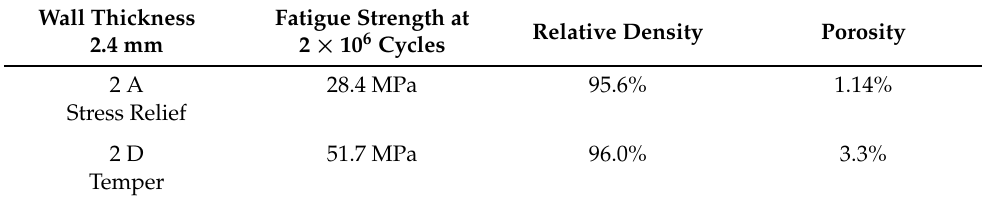
Table 3. Characteristics of the samples with a thickness of 1.4